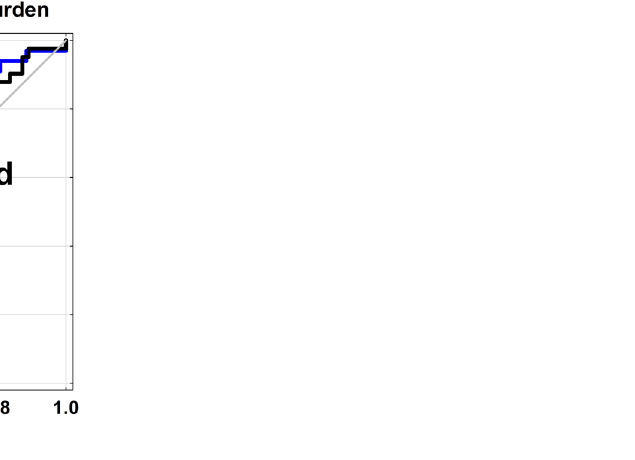
Figure 2. ROC curve of extracellular volume (ECV) and indexed left ventricle end-diastolic diameter (LVEDd) with cut-off points for the presence of arrhythmic